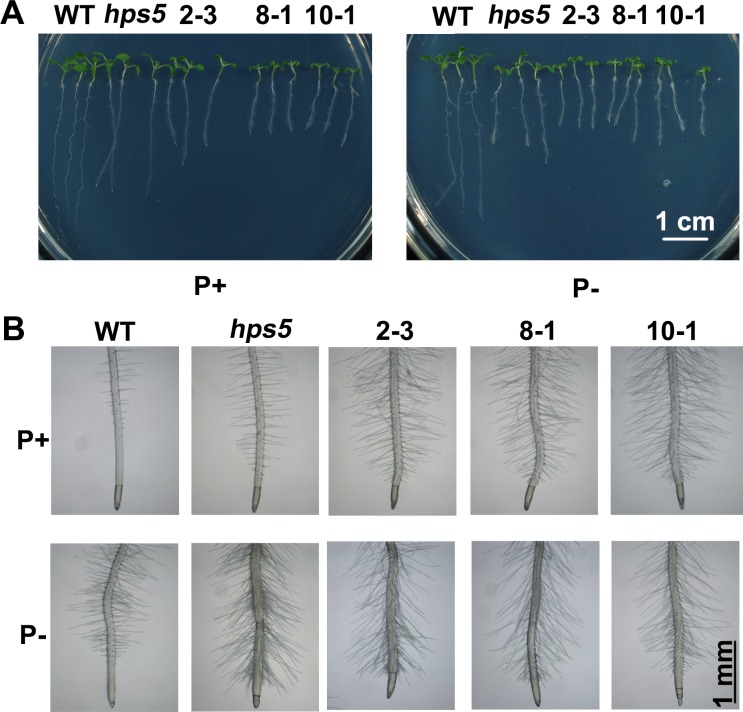
The dominant-negative effect of the hps5 mutation.(A), Morphology of 7-day-old seedlings of the WT, hps5, and three 35S::mERS1 transgenic lines grown on P+ and P- media. (B), A close view of the root tips of the seedlings in (A). In (A) and (B), the numbers at the top are the names of the transgenic lines.